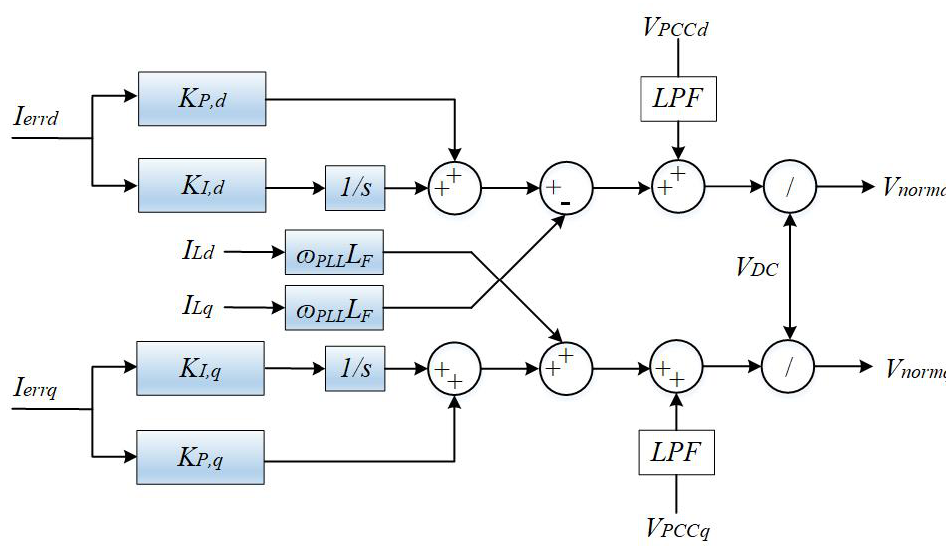
Figure 4. Control structure of the current controller (PI cc ) in Figure